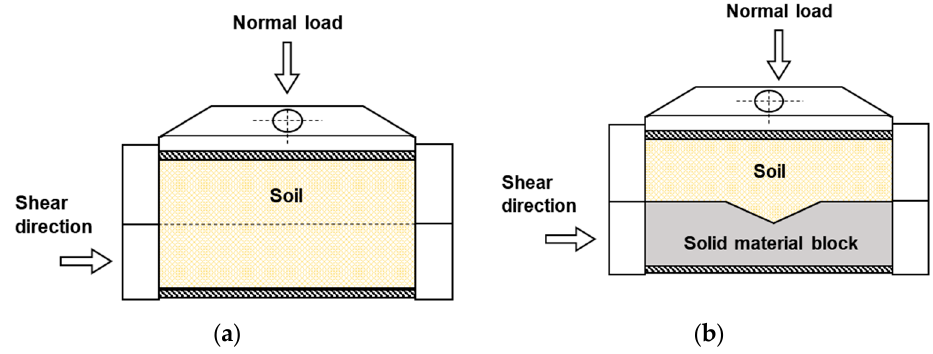
Figure 4. Schematic diagram of experimental setup: ( a ) direct shear test; ( b ) interface shear